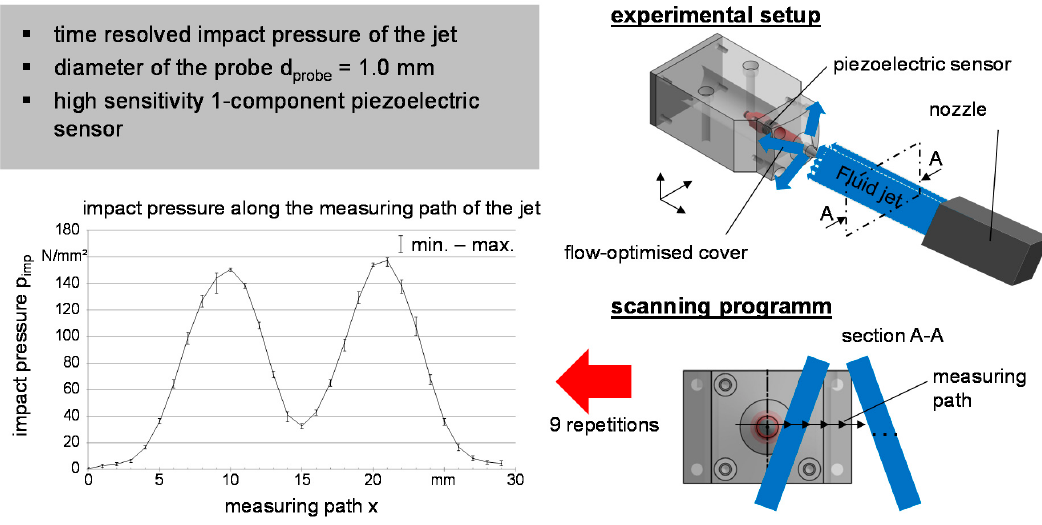
Figure 4. Experimental setup, scanning program and repeatability for impact pressure measurement.